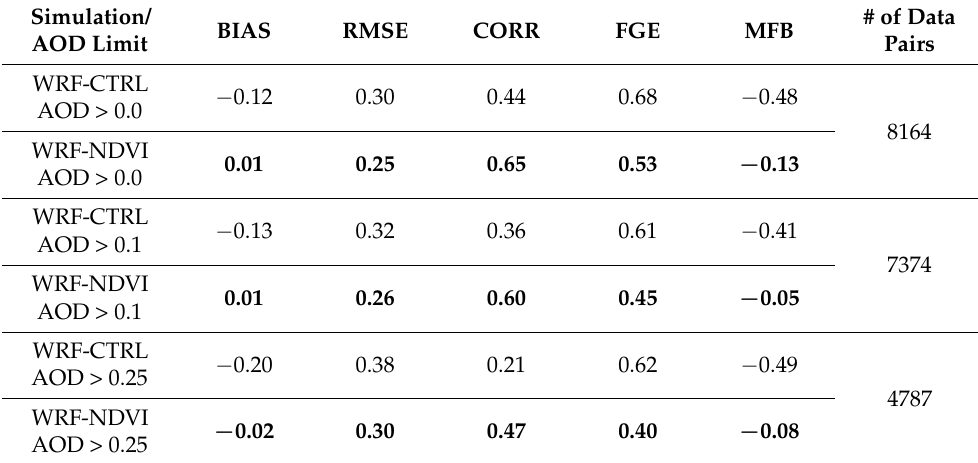
Table 2. Statistical indexes for the two simulation sets (WRF-CTRL and WRF-NDVI) for the three AOD limits used. The total number of data pairs used for the calculation of the statistics are presented in the last column. Bold fonts indicate model improvement for the corresponding statistical value.